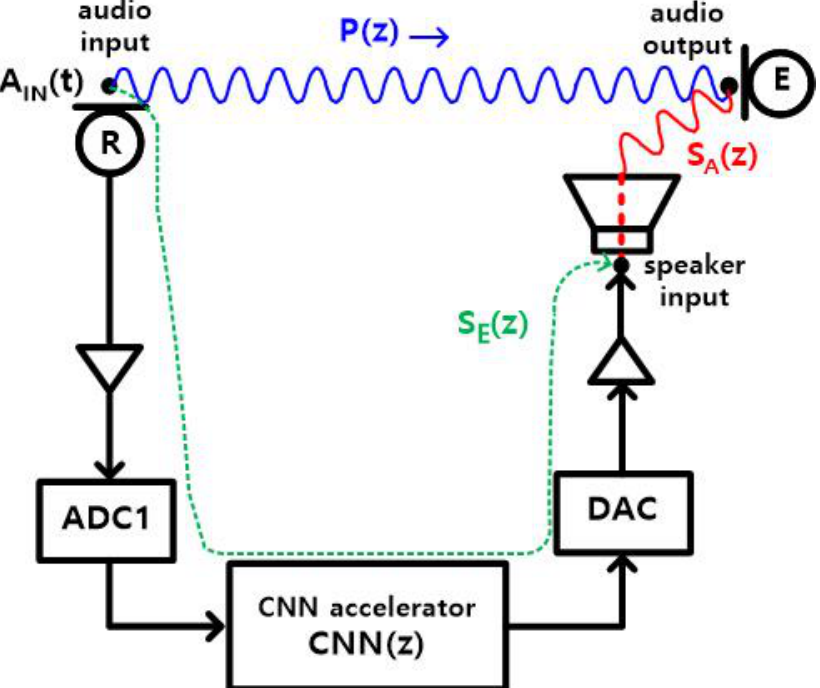
Figure 4. Proposed feedforward ANC of this work, using a CNN accelerator in FPGA. Blue: Primary path, Green: Electrical secondary path, Red: Acoustic secodnary